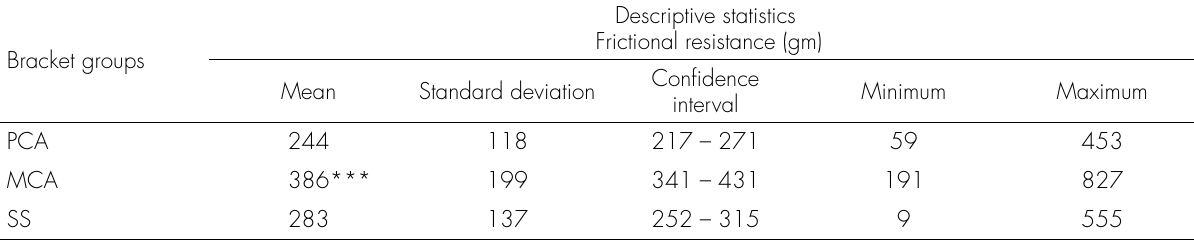
Table II. Descriptive statistics of the overall resistance to sliding among brackets groups (dry environment). (PCA) polycrystalline alumina. (MCA) monocrystalline alumina ceramic brackets. (SS) stainless steel.